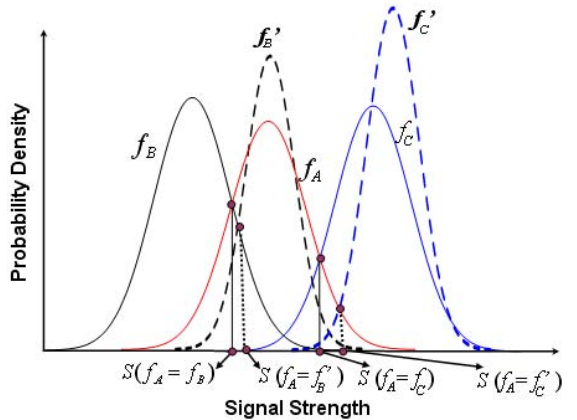
Figure 5. Probability density functions of signal strength received from three beacon